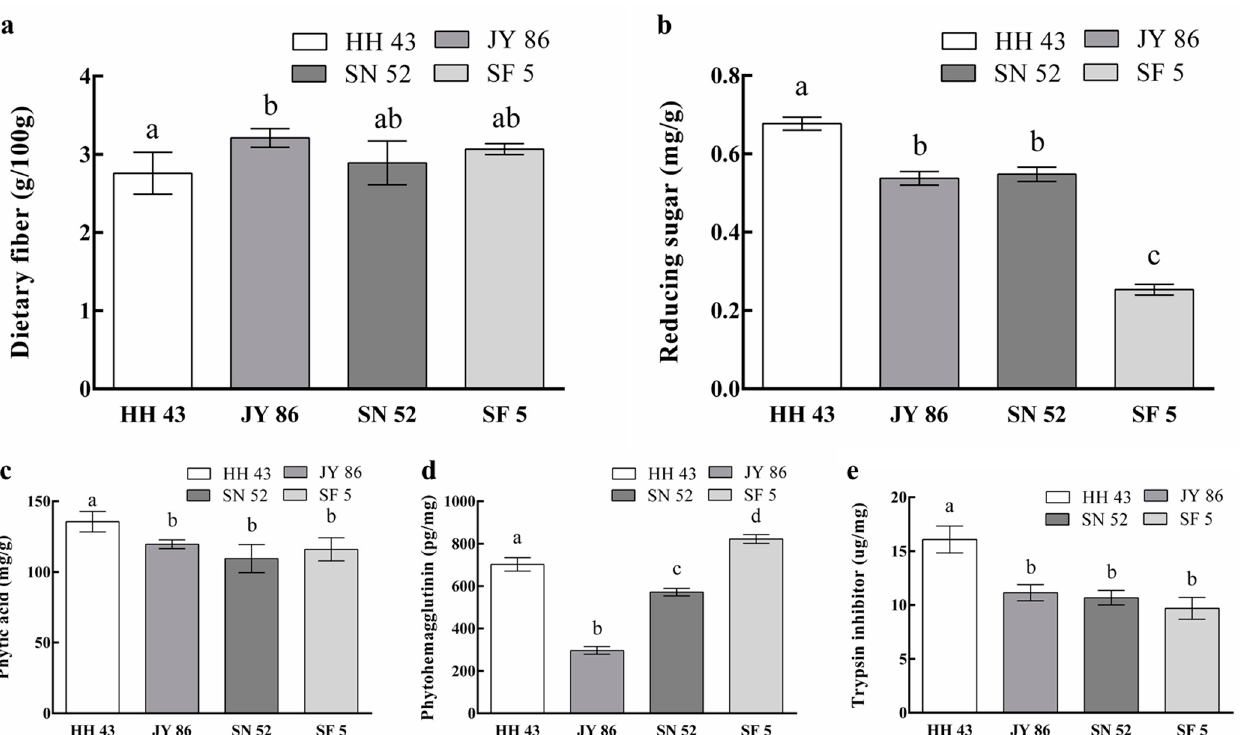
Figure 3. Nutritional properties of four kinds of plant-based meat analogues (PBMs): ( a ) The dietary fiber content; ( b ) The reducing sugar content; ( c ) The phytic acid content; ( d ) The phytohemagglutinin content; ( e ) The trypsin inhibitor content. Different lowercase letters indicate a significant difference [ p < 0.05]).